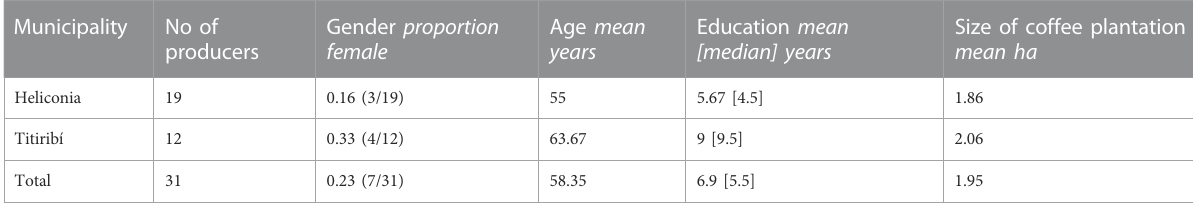
TABLE 3 Summary of socio-demographic characteristics of the interviewed